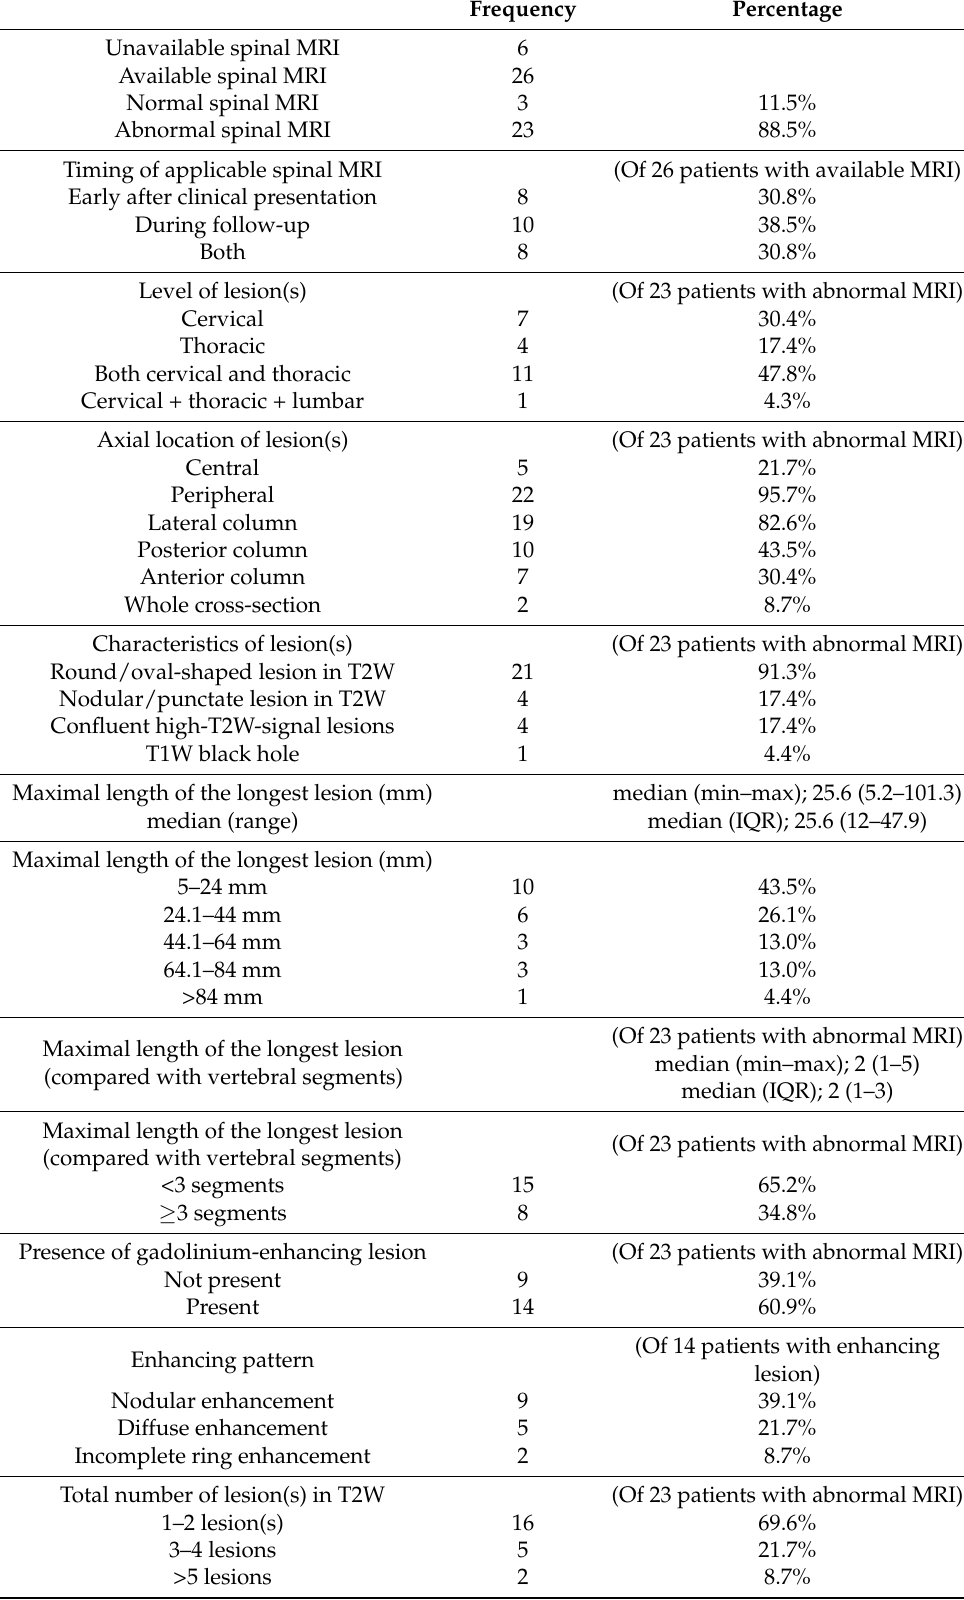
Table 3. Spinal MRI findings (Spinal MRI was applicable in 26